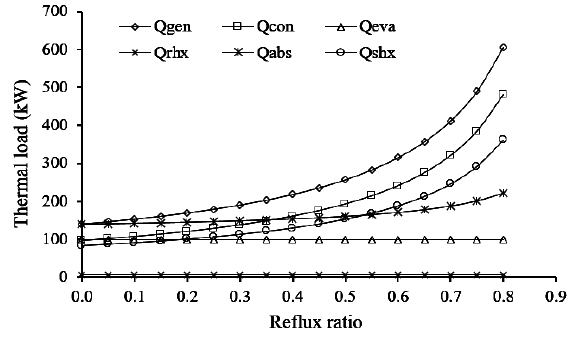
Figure 16. Effect of reflux ratio on components’ thermal loads.